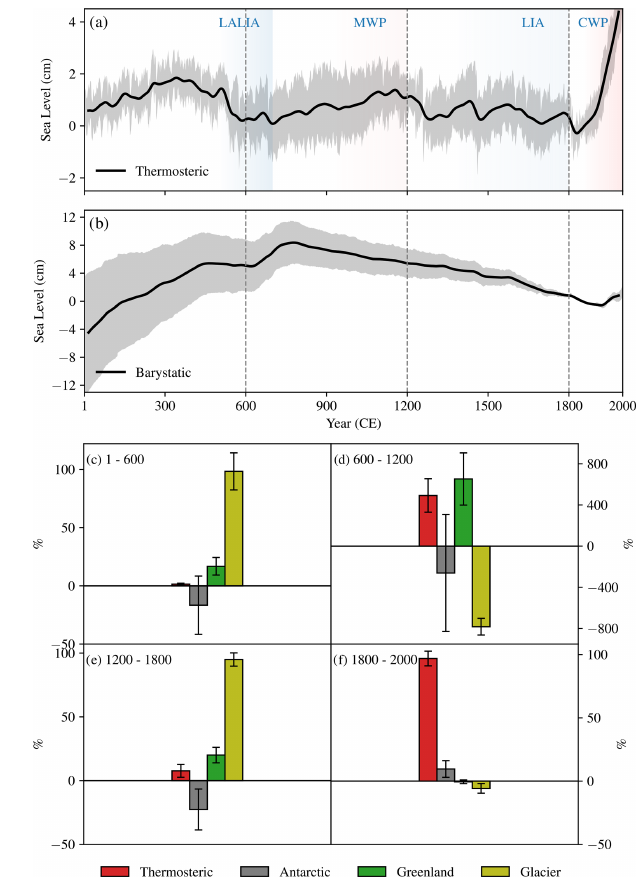
Figure 5. Global-mean thermosteric (a) and barystatic (i.e. the sum of Antarctic, Greenland and glacier contribution; b ) sea levels with their 1 σ uncertainty levels from EXP-I (a 31-year smoothing is ap- plied on the sea-level curves to focus on centennial time scales). We defined four time periods in the CE (1–600, 600–1200, 1200–1800 and 1800–2000; shown by dashed vertical lines in a and b ) based on centennial-scale shifts seen in the global-mean thermosteric sea level. These periods also mark the major sub-millennial climate epochs reported in the CE: the Late Antique Little Ice Age (LALIA, ∼ 600–700), the medieval warm period (MWP, ∼ 900–1300), the Little Ice Age (LIA, ∼ 1300–1800) and the current warming period (CWP, post-1800). The respective contributions of thermosteric, ice-sheet and glacier mass-balance changes to the model GMSL is estimated for these four periods and shown in panels (c) (1–600), (d) (600–1200), (e) (1200–1800) and (f) (1800–2000). The percent- age contribution is calculated by a linear regression method, and the error bar represents the 1 σ standard deviation of the contribu- tion across the large